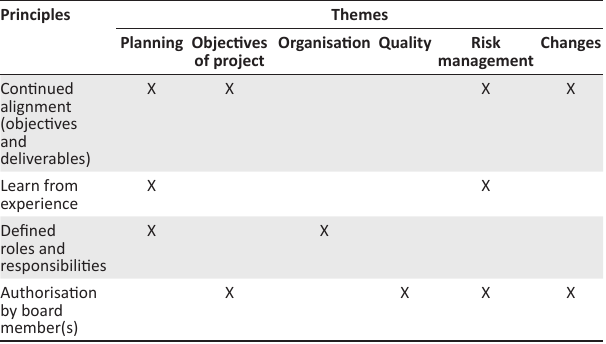
TABLE 4: Basis of Projects in Controlled Environments for small- and medium- sized